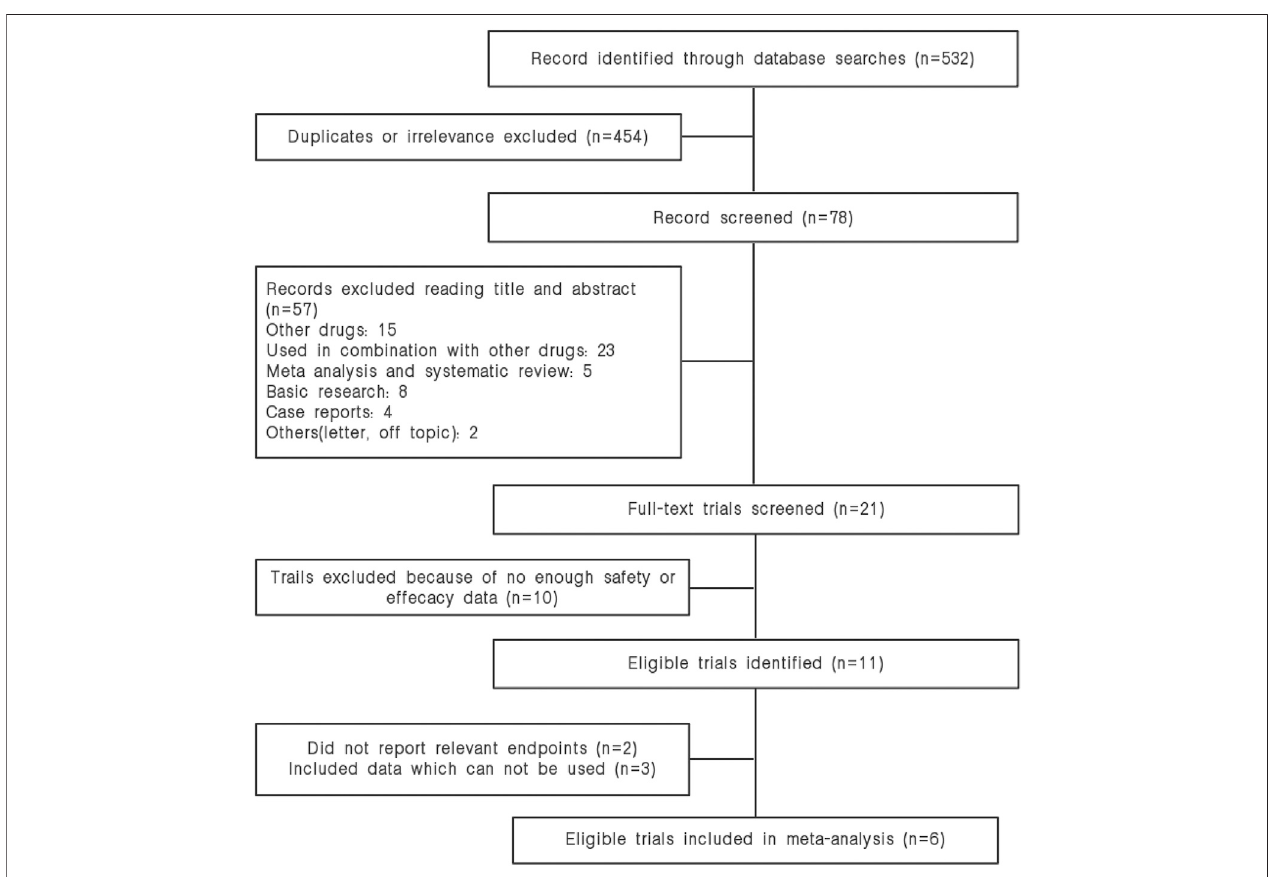
FIGURE 1 | Flow diagram for identi fi cation and selection of studies included in the meta-analysis.